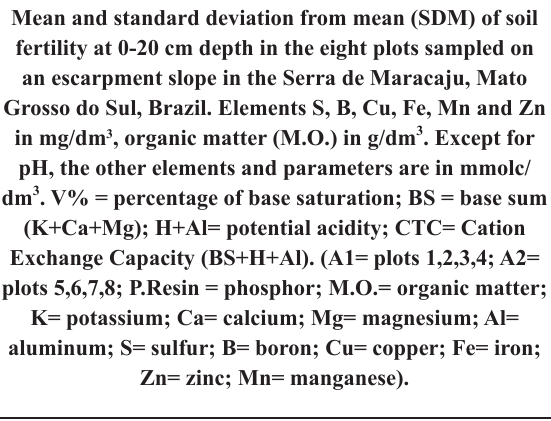
Mean and standard deviation from mean (SDM) of soil